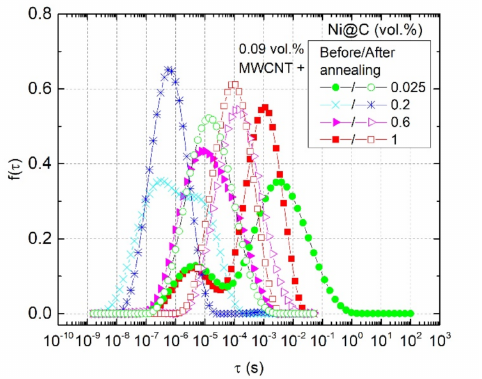
Figure 15. Relaxation time distributions for hybrid Ni@C/MWCNTs/epoxy composites before and after annealing at 500